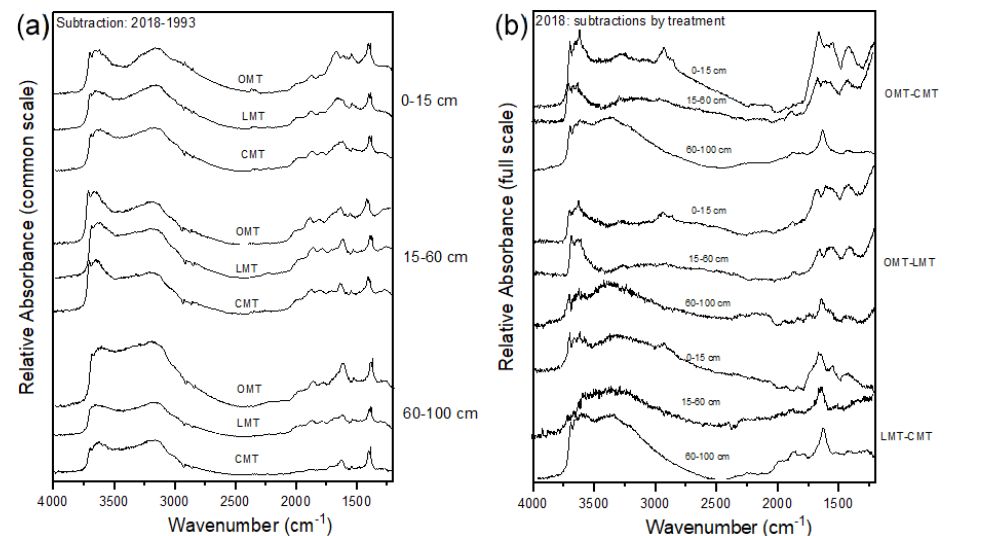
Figure A3. (a, b) FTIR spectral subtractions for the 4000–1200cm − 1 range comparing (a) 2018–1993 spectra for ORG, CONV + WCC, and CONV and (b) ORG, CONV + WCC, and CONV spectra in